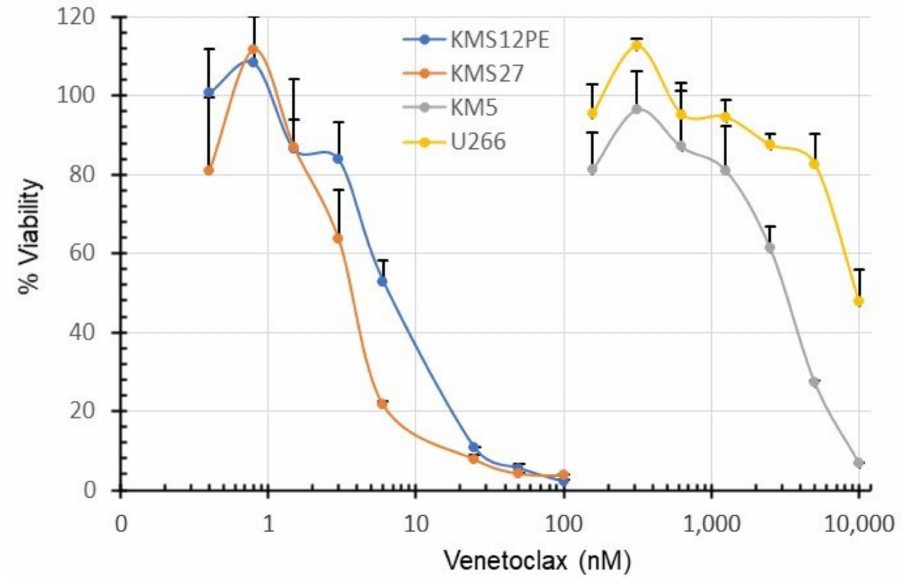
Figure 3. Cytotoxicity of venetoclax to MM cell lines. MM cell lines were treated with venetoclax at the indicated concentrations and cultured for 48 h. The x-axis represents the concentration of venetoclax. The x-axis was formatted to have a base 10 logarithmic scale. The y-axis shows % viability. Viability values on each point is shown as 100% at 0